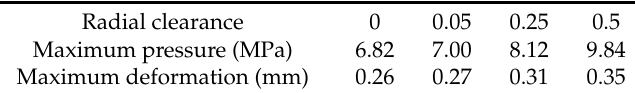
Table 2. Maximum values along the gait cycle of the pressure and deformation on the inner face of the